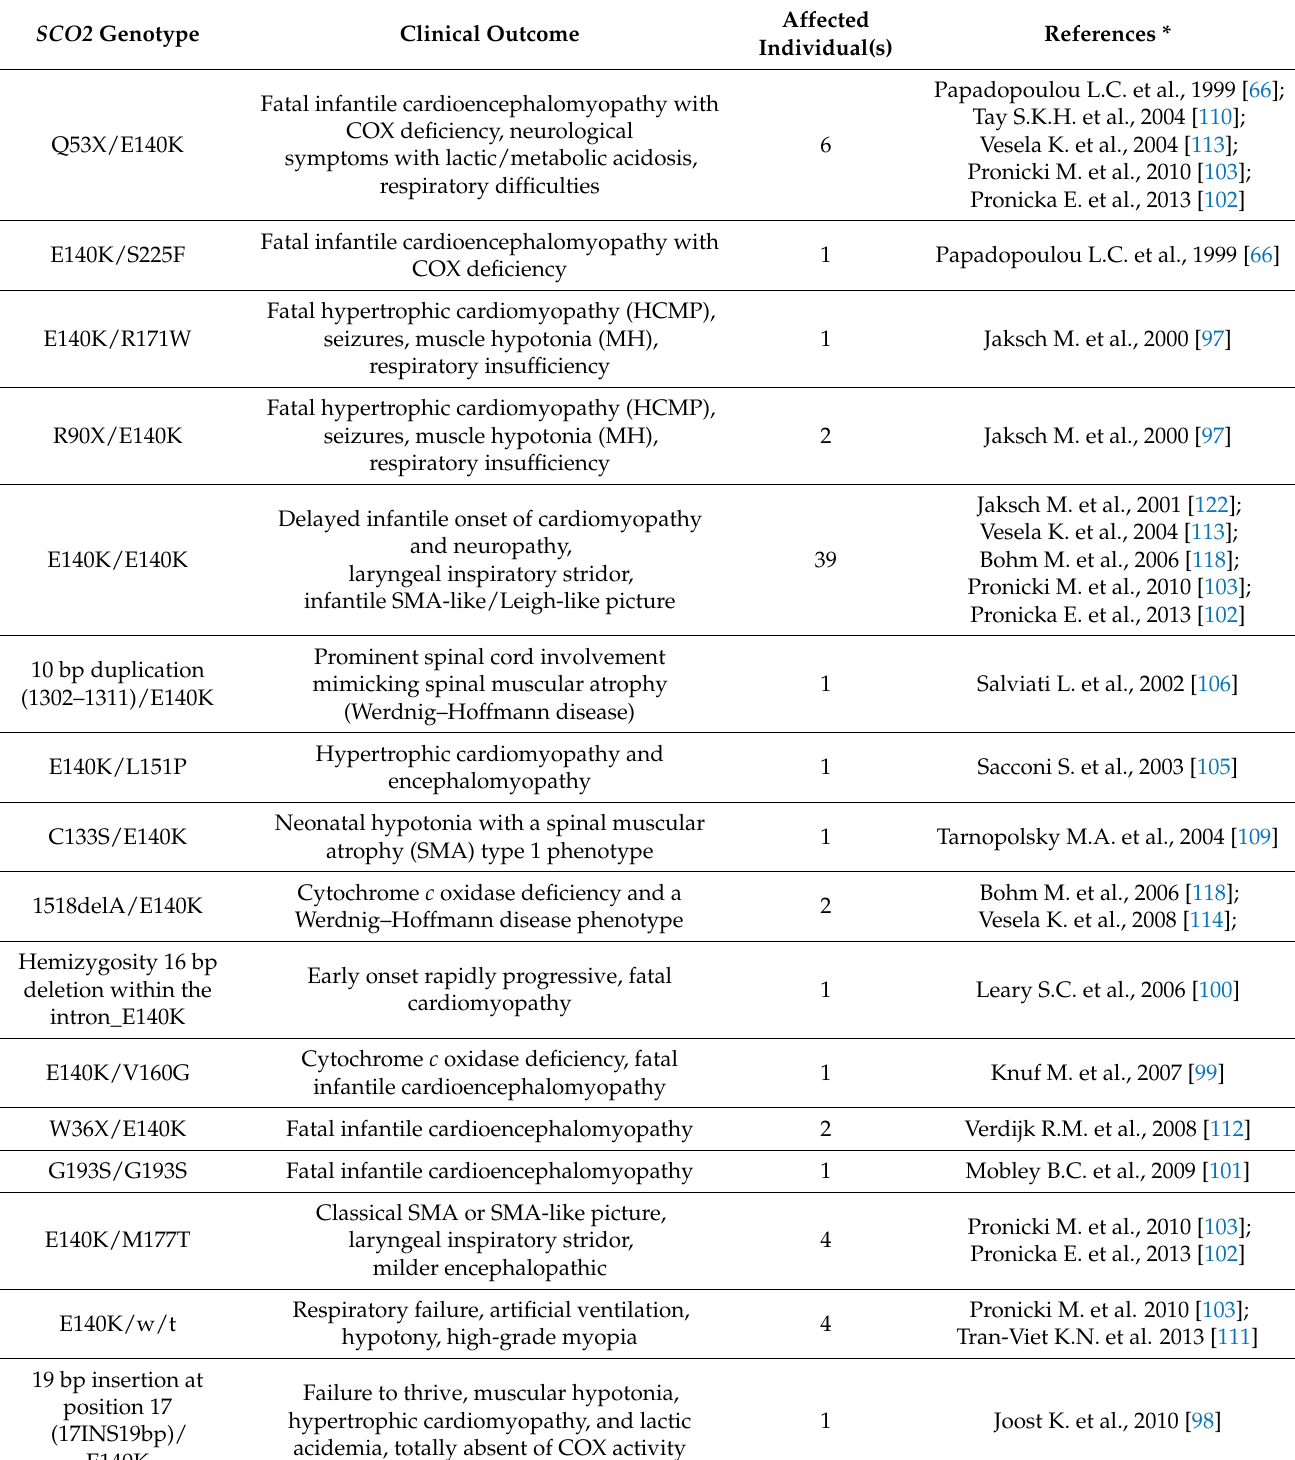
Table 1. Reported Sco2 mutations and associated